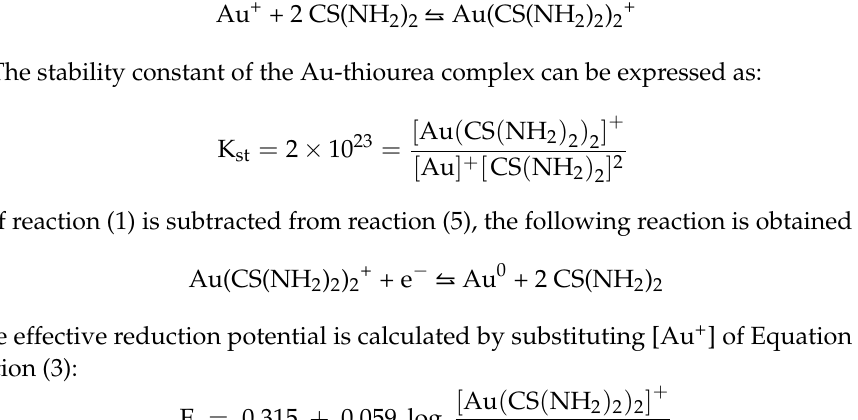
Figure 1. Potential ‐ pH equilibrium diagram illustrating features of the Au ‐ thiourea ‐ H 2 O and Au ‐ cyanide ‐ H 2 O systems at 25 °C. [CN − ] total = 1 × 10 − 4 mol/L, Au(CN) 2 − = 1 × 10 − 3 mol/L, Au + = 5 × 10 − 4 mol/L, CS(NH 2 ) 2 = 0.33 mol/L, Fe 3+ = 0.11 mol/L.